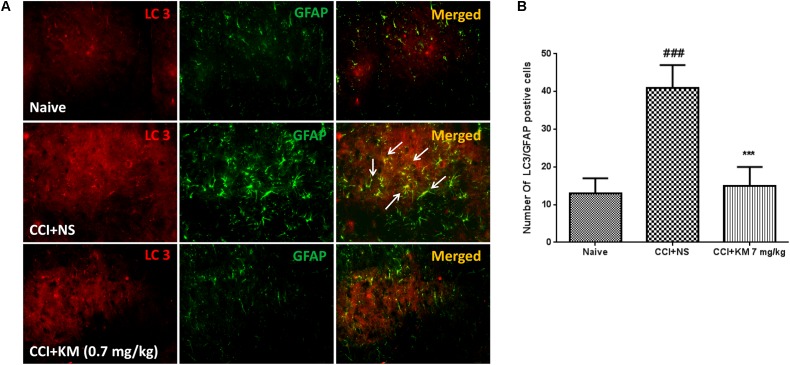
Koumine (KM) inhibit GFAP protein levels in rat spinal cord with CCI neuropathy. (A) After CCI or Sham surgery, koumine (0.28, 7 mg/kg) or vehicle was administered s.c. once a day, every day for seven consecutive days from postoperative TSPO and LC3 was determined by Immunofluorescence. (B) The number of LC3/GFAP positive cells. The scale bar represents 25 μm. Data are expressed as the mean ± SEM. ###P < 0.001 versus Sham group. ∗∗∗P < 0.001 versus vehicle control group, separate one-way ANOVA followed by LSD test.